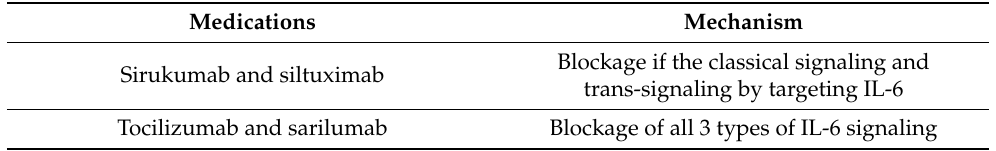
Table 3. Mechanism of individual